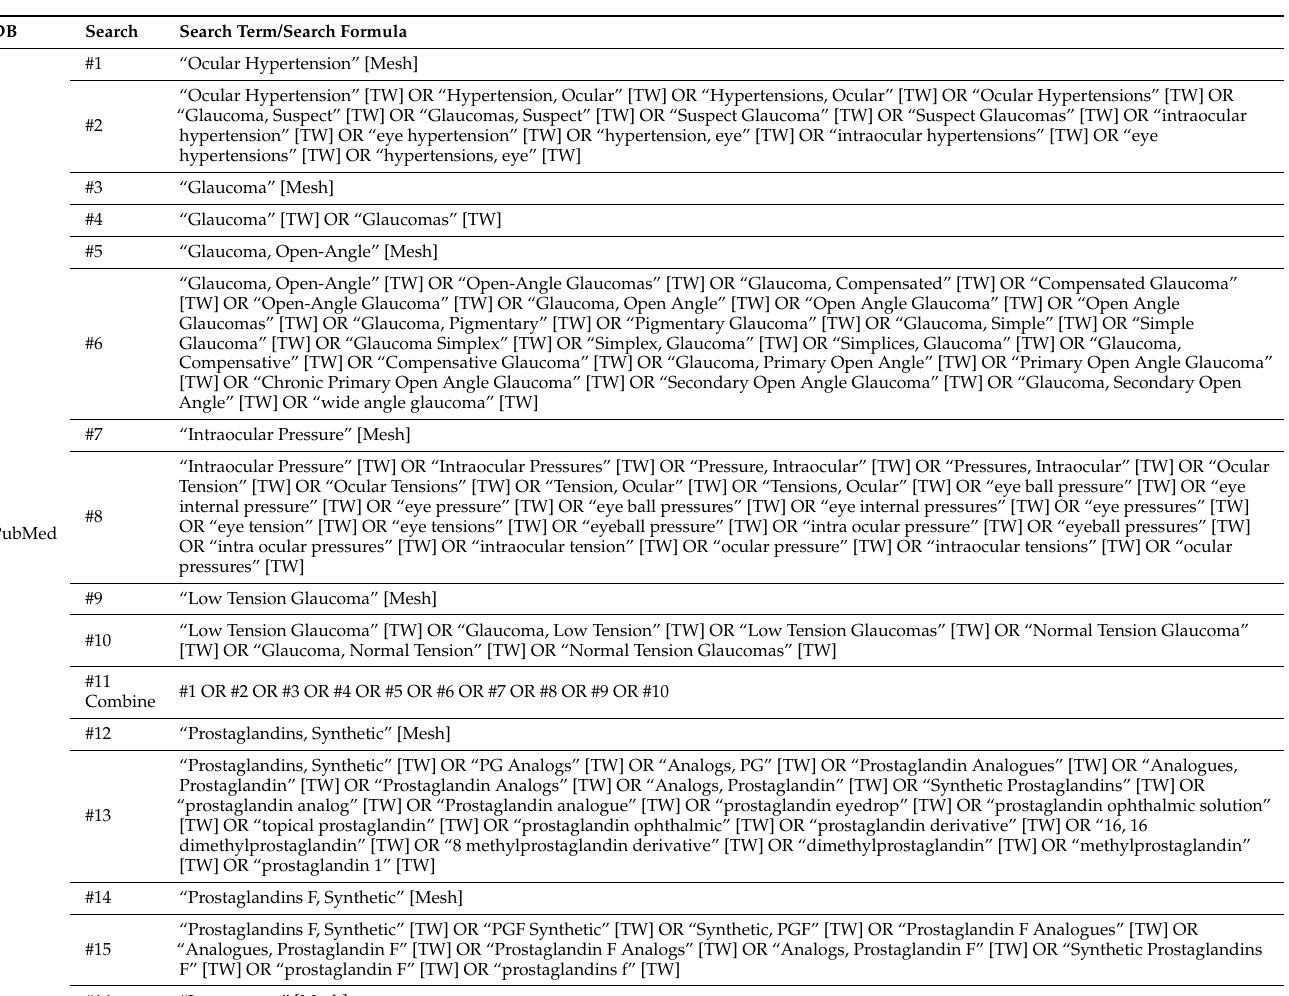
Table A1. Search terms and formula for Pubmed